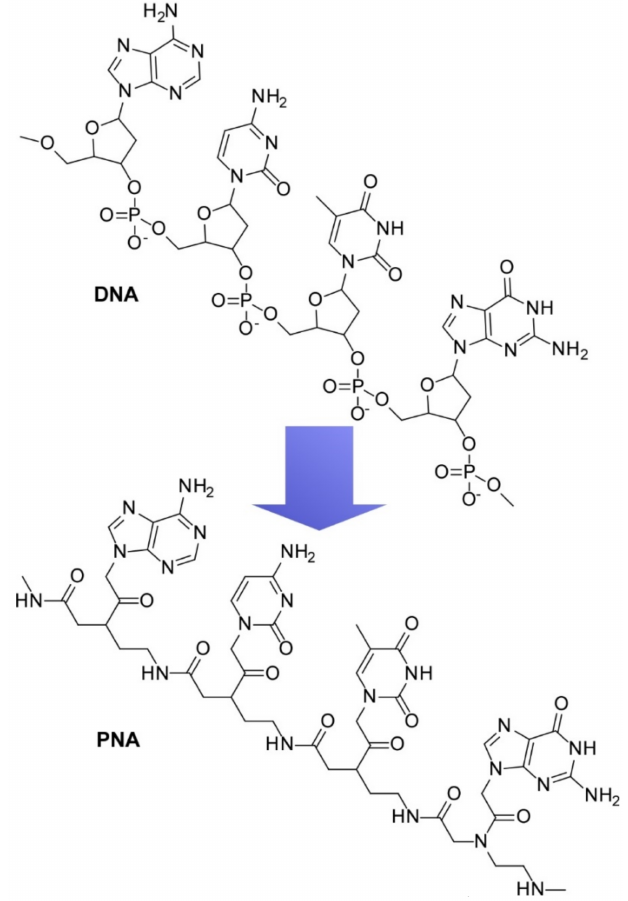
Figure 12. A peptide nucleic acid (PNA) as an artificial mimic of DNA.